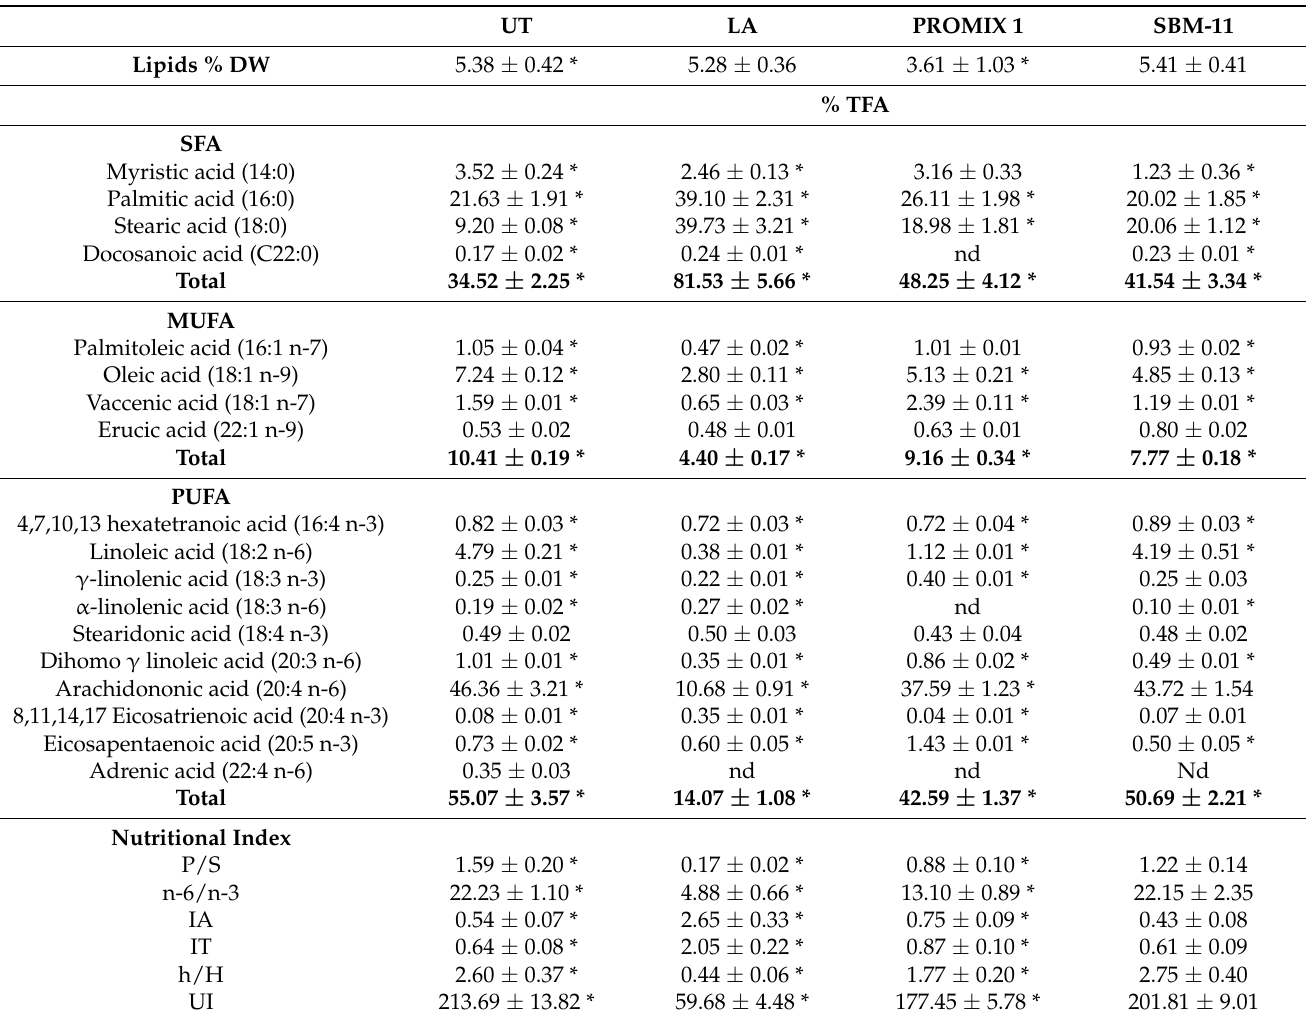
Table 4. Fatty acids composition (as percentage of total fatty acids, TFA) of untreated control (UT) and in fermented seaweed. LA: Lactobacillus acidophilus SBM-11: a mix of Lactobacillus sakei , Staphylococcus carnosus and Staphylococcus xylosus ; PROMIX 1: Staphylococcus xylosus . Data shown are the mean ± SD ( n = 3). Asterisk indicates statistically significant differences ( p < 0.05) between each treatment (LA, PROMIX 1, SBM-11) versus untreated control (UT), as determined by the two sample- t